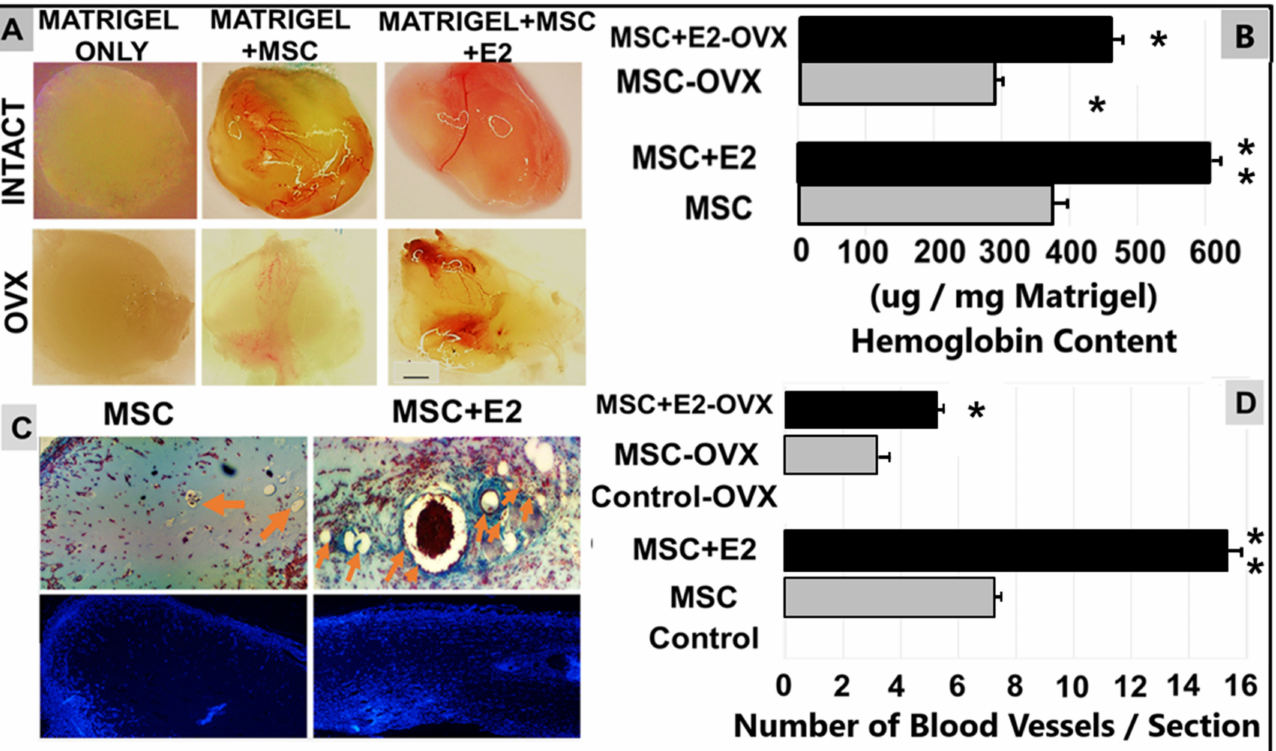
Figure 1. E2 enhances angiogenesis effects in Matrigel ® plugs containing MSCs. ( A ) Exhibits a macroscopic view of Matrigel ® plugs from each group—sham-operated or OVX—in presence or absence of E2 (100 nM): C57Bl mice injected with Matrigel ® only, Matrigel ® + cells (Matrigel ® + MSC), or Matrigel ® + hormone-treated cells (Matrigel ® + MSC + E2). ( B ) Displays measures of hemoglobin content using Drabkin’s reagent kit of Matrigel ® implants from both groups. The levels of this angiogenesis marker were amplified in MSCs stimulated with the sex hormone (MSC + E2 ± OVX) in comparison with control (MSCs only). Each value corresponds to mean ± SEM ( n = 3); * p < 0.05, ** p < 0.01 compared with control. ( C ) Descriptive photomicrographs of Matrigel ® -derived blood capillaries/vessels embedded in paraffin and stained with hematoxylin & eosin, and DAPI; Orange arrows indicate blood vessel structures; scale bar—100 µ m. ( D ) Quantification of the new blood vessels was presented as mean ± SD ( n = 2), ** p < 0.01, and * p < 0.001 compared with control. Note: E2, 17-beta estradiol; MSCs, Wharton’s jelly-derived mesenchymal stem cells; OVX, ovariectomy